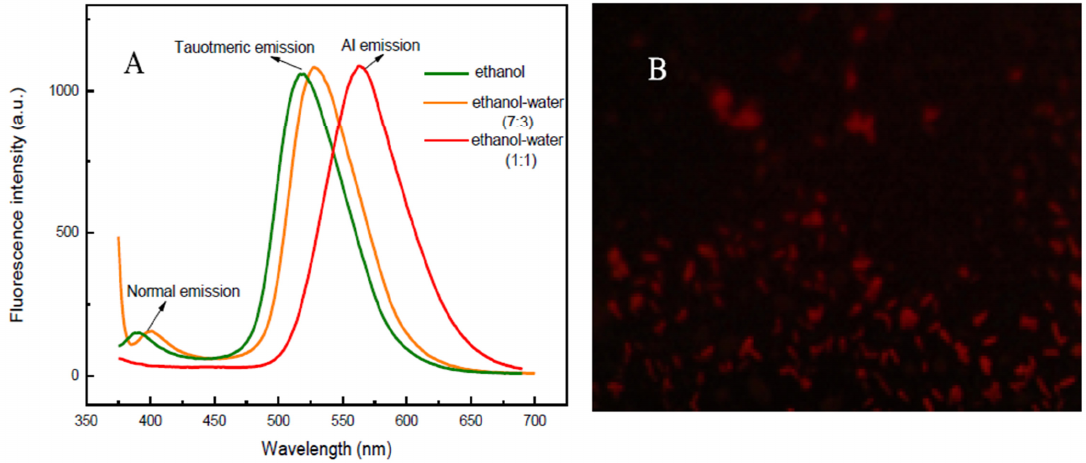
Figure 2. ( A ) Fluorescence spectra of 2-APC in ethanol and ethanol–water mixture; ( B ) Fluorescence microscopic image of 2-APC in ethanol–water system (1:1, v/v ). The photograph was taken under 365 nm UV lamp. The concentrations of 2-APC are 15 µ M L − 1